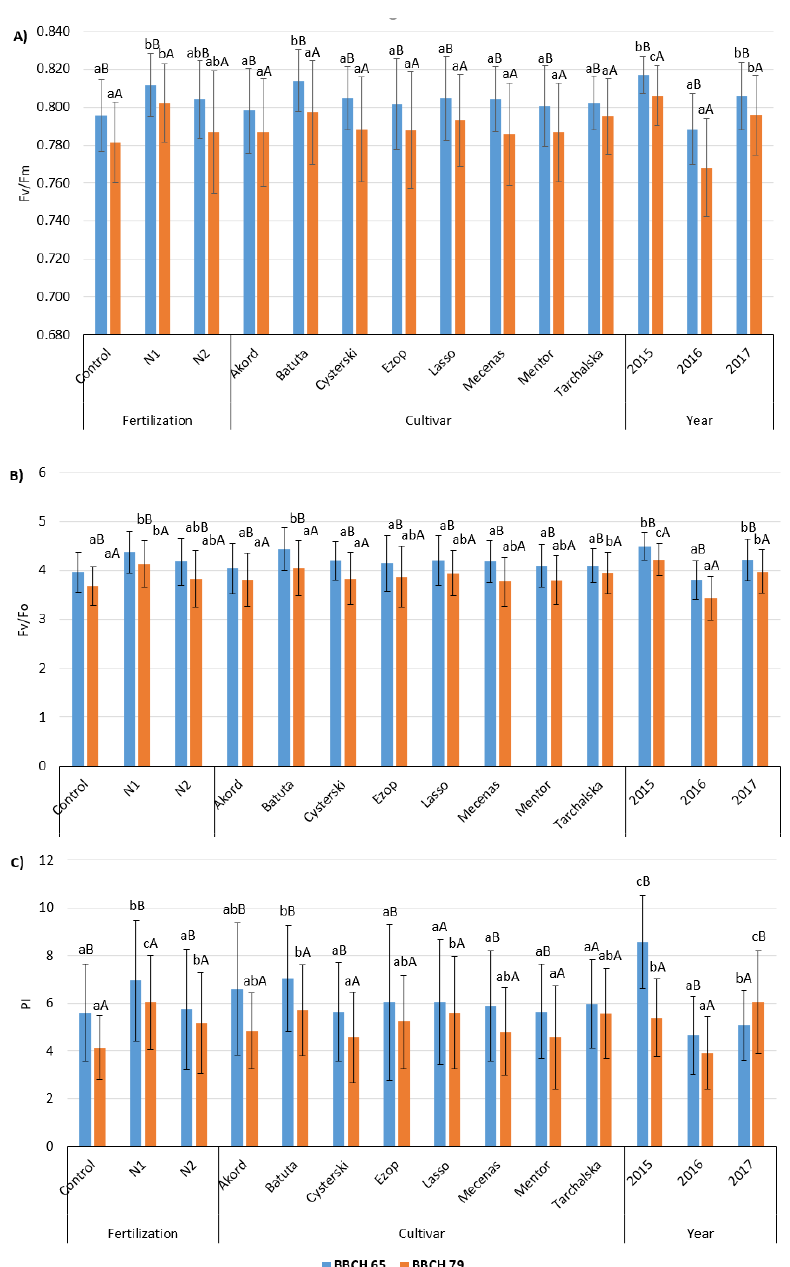
Figure 3. Effect of interaction of foliar fertilization and years in shaping Chl fluorescence parameters measured in pea bracts: ( A ) F v /F m , ( B ) F v /F 0 , ( C ) PI. N1 — fertilizers/biostimulators of plant origin, N2 — biostimulants of animal origin. Error bars are standard deviations of the means. Different letters above the columns indicate significant difference between treatments: small letters for fertilization and capital letters for measurement terms (ANOVA, Tukey test) at p < 0.05.